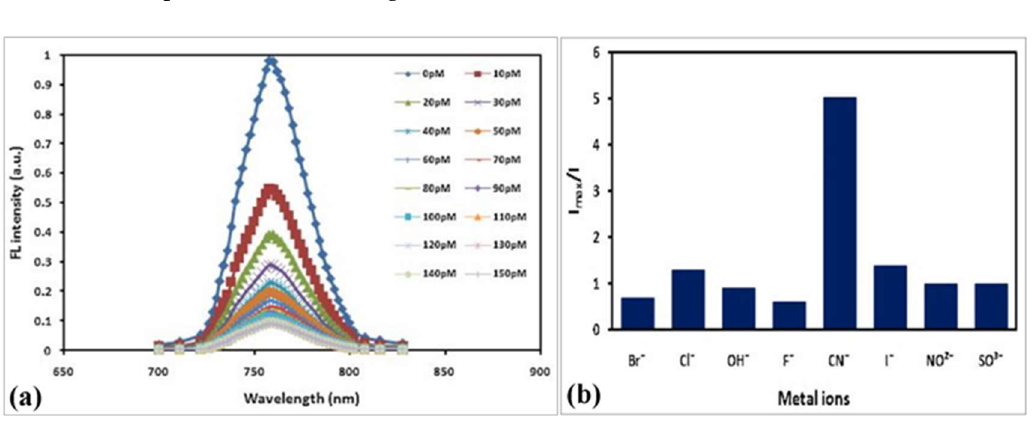
Figure 25. ( a ) FL intensity for functionalized InP QWs at different cyanide concentration. ( b ) Relative intensity for functionalized InP QWs for various metal anions at 50 pM concentration [71].